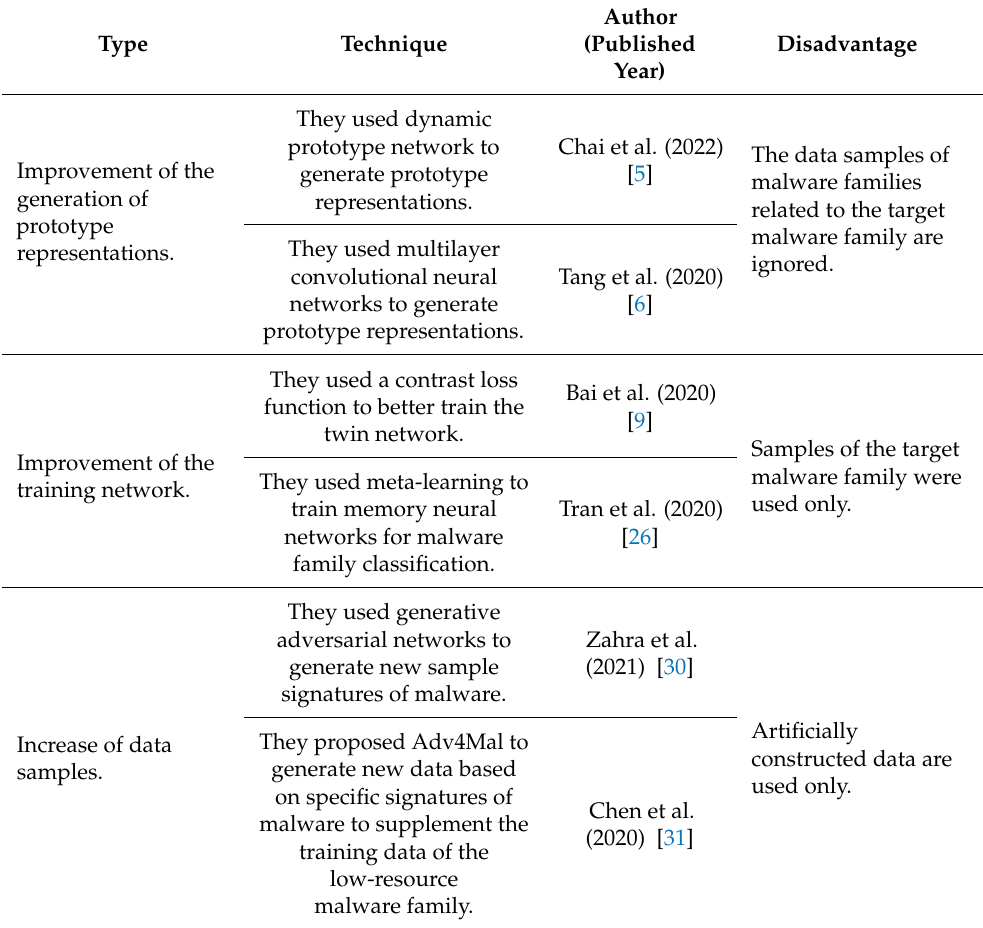
Table 1. Low-resource malware detection based on machine